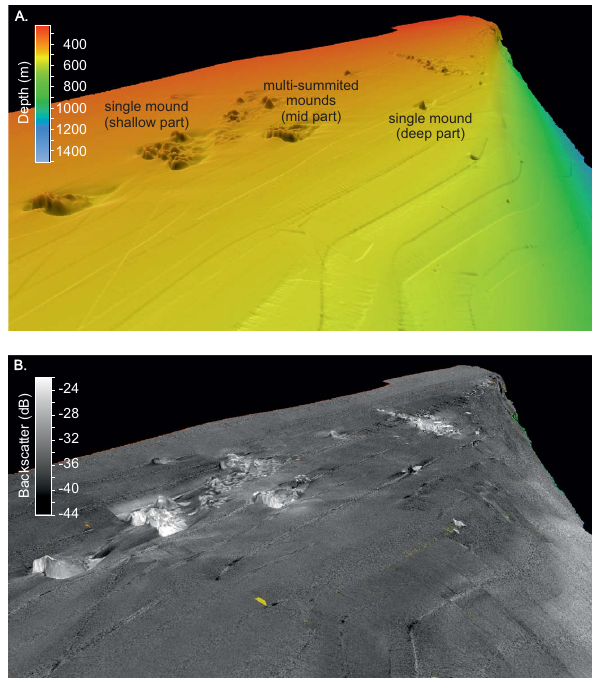
Fig. 3. 3-D multibeam bathymetry (A) and backscatter map (B) of the research area. Different mound morphologies were observed on the shallow, mid and deep part of the mound area. Mounds are char- acterised by high backscatter (bright